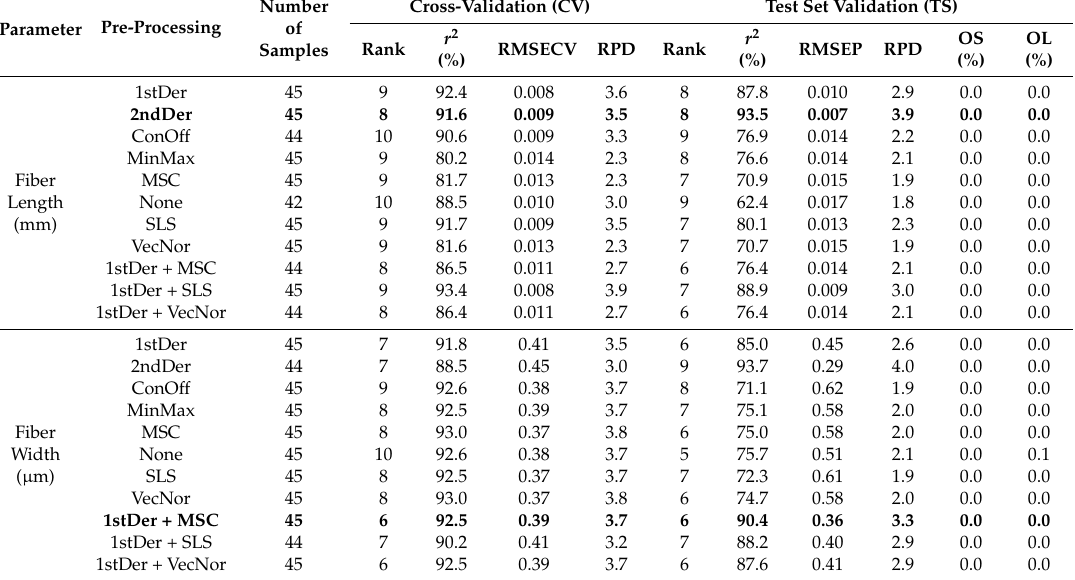
Table 2. Results of the cross-validation of the calibration set (45 samples) and of the test set validation (15 samples) including percentage of outsiders (OS) and outliers (OL) of the test set obtained during prediction of the samples with unknown fiber length (weighted in length) and width, using various pre-processing methods of the raw spectral data. In bold: cross-validation for the best model with test set validation.